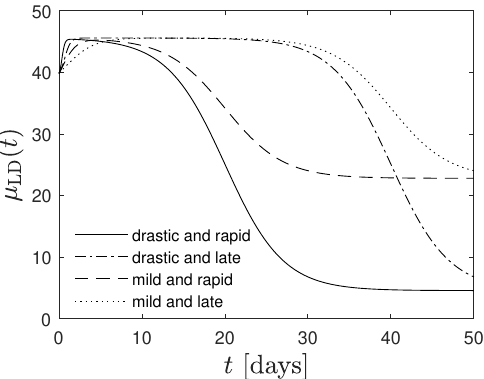
Figure 9. The lockdown recovery rate, µ LD ( t ) (21), in the case of pre-specified lockdown infection rate, a LD (19), using k 0 = 0.7, k 1 = 0.8, a 0 = 57 days − 1 , t b = 7 days, τ c = a 0 t a , ∆ = 10 qt a for the four cases: drastic ( q = 0.1) and rapid ( t a = 20 days); drastic ( q = 0.1) and late ( t a = 40 days); mild ( q = 0.5) and rapid ( t a = 20 days); and mild ( q = 0.5) and late ( t a = 40 days), as